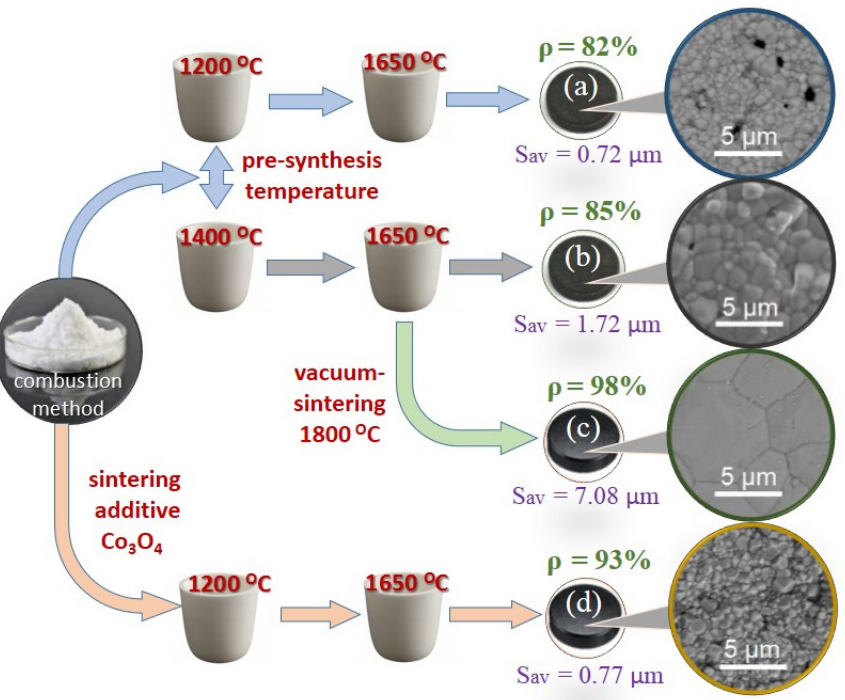
Figure 4. Sintering scheme for La 0.95 Ba 0.05 ScO 3- δ ceramics. ρ is the relative density, and S av is the average grain size. The explanation for subfigures are in the text of the paper.